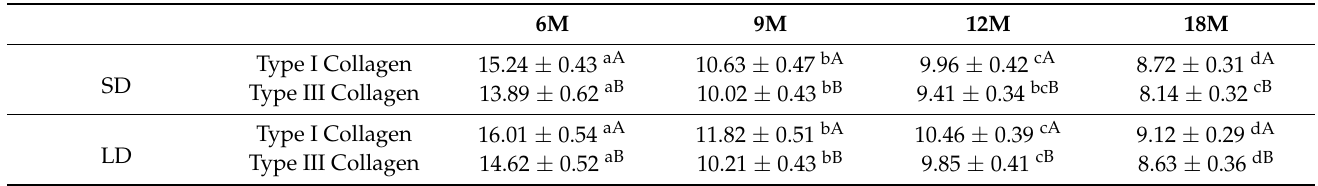
Table 2. The percentage of type I and III collagen solubility from Semitendinosus (SD) and Longis- simus dorsi (LD) in different growth